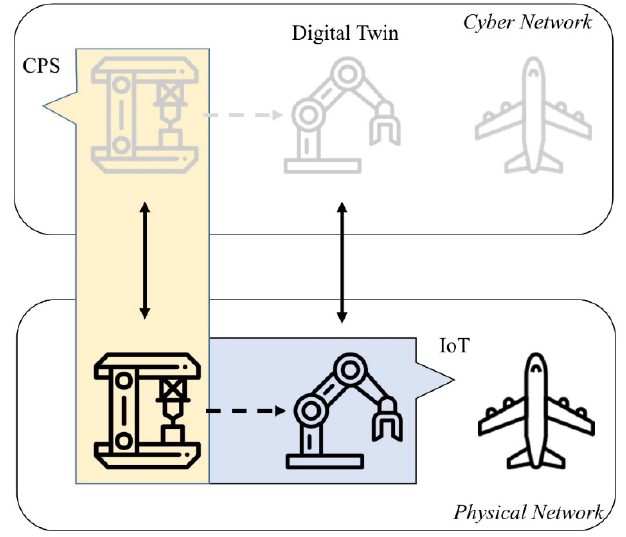
Figure 1. Two parallel networks and the relationship between IoT, Digital Twin and CPS.